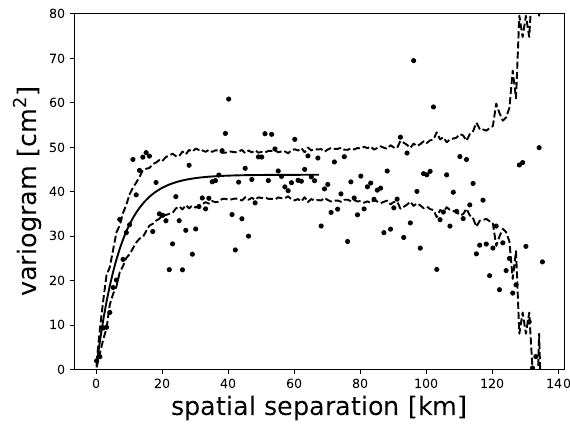
Table 2: Root-Mean-Squares (RMS) of τ i are shown (NMA2013v30). All observations within a distance ∆ min of location i are disregarded in the computation of the prediction at location i . The sample con- sists of the m = 3, 297 observations available for mainland Norway.